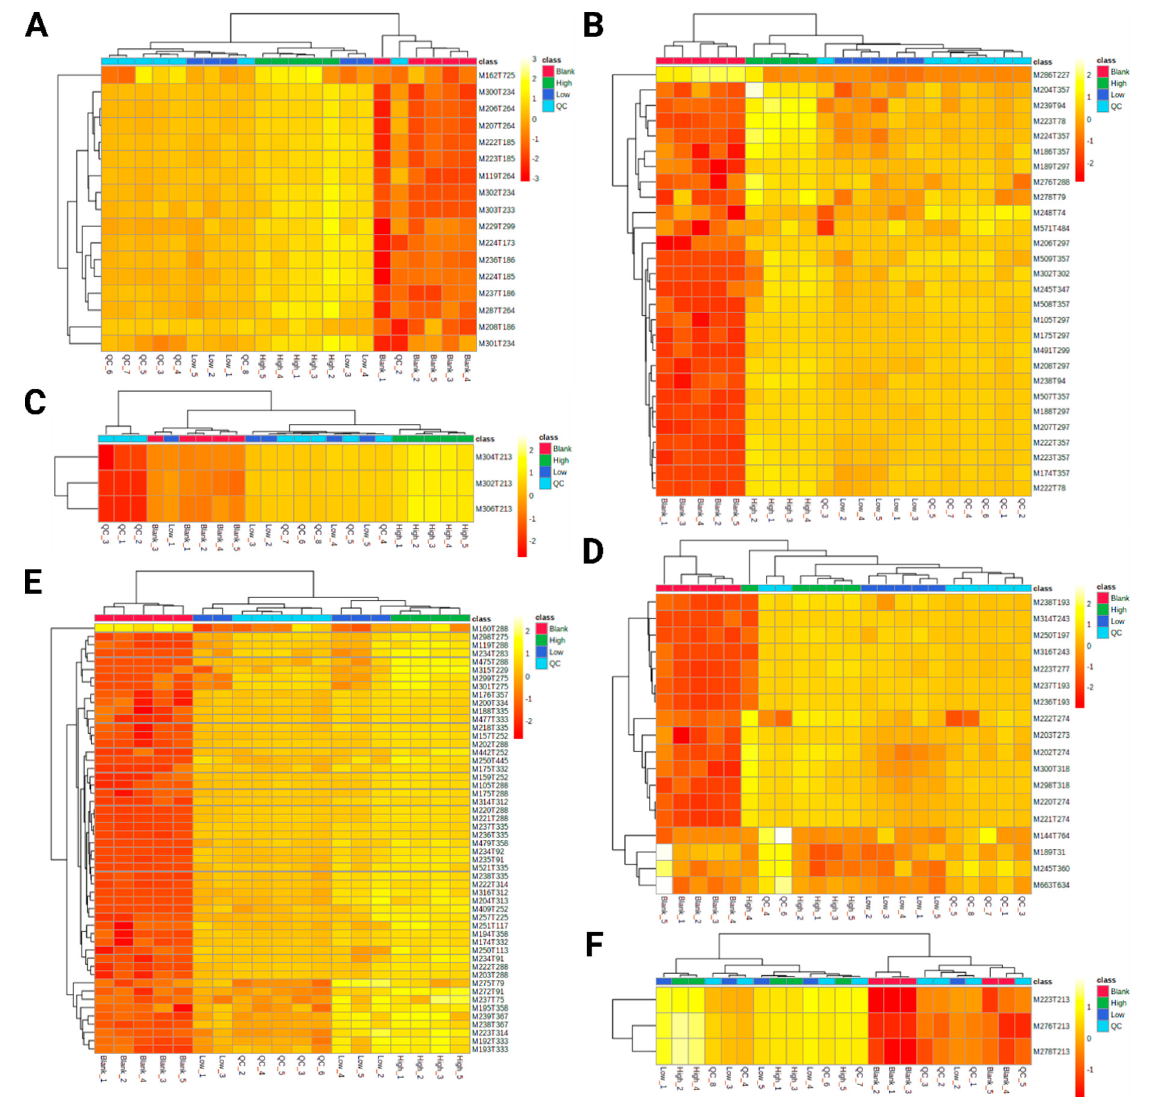
Figure 2. Heatmaps containing z -scores of the features’ abundances after hierarchical clustering. ( A ) 4-MPD, reversed phase chromatography, positive ionization mode; ( B ) 4-MPD, normal phase chromatography, positive ionization mode; ( C ) 4-MPD, normal phase chromatography, negative ionization mode. ( D ) 4-MEAP, reversed phase chromatography, positive ionization mode; ( E ) 4-MEAP, normal phase chromatography, positive ionization mode; ( F ) 4-MEAP, normal phase chromatography, negative ionization mode.